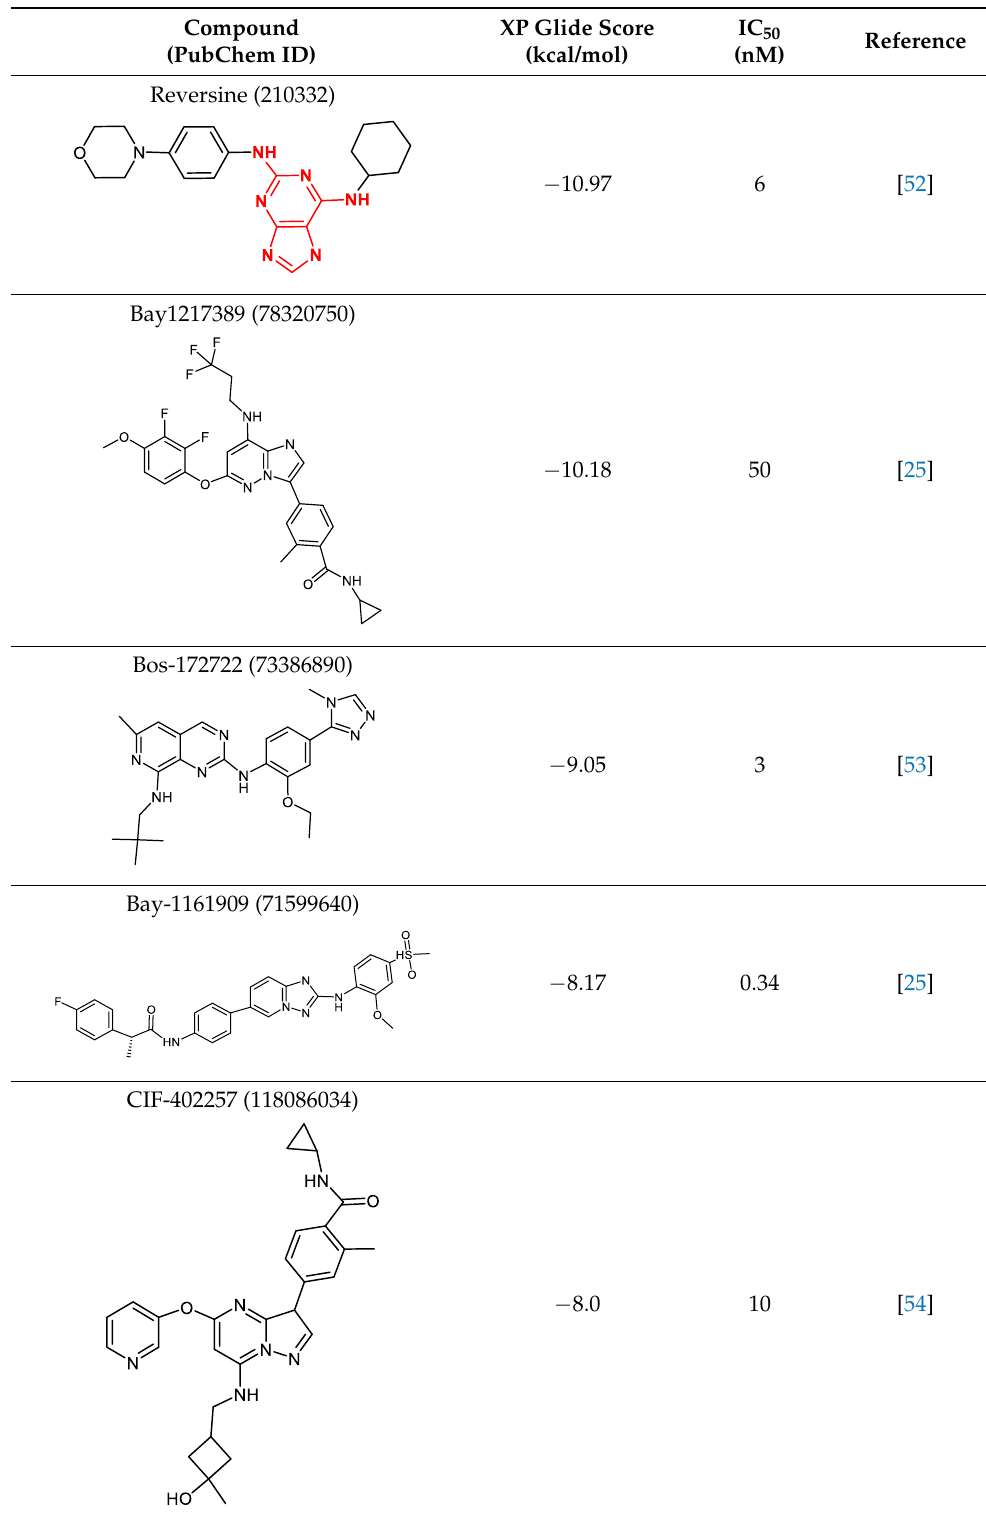
Table 1. Mps1 kinase inhibitors selected for HTVS.